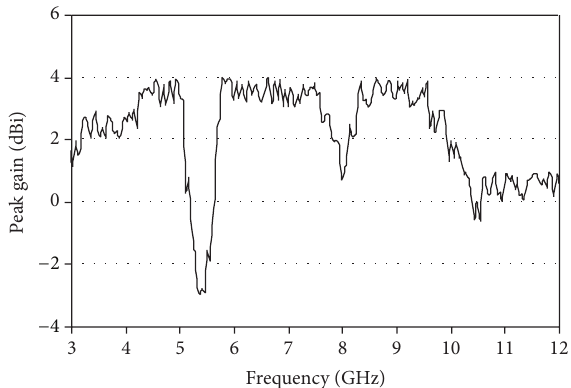
Figure 7: Measured peak gain of the proposed